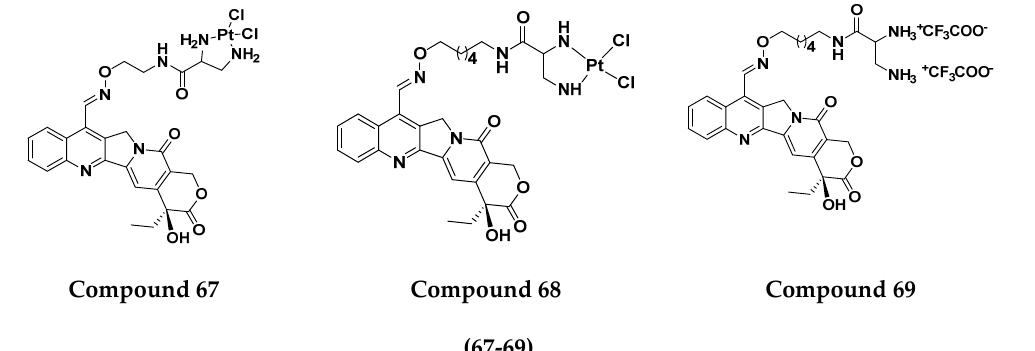
Figure 66. Structure of Camptothecin-linked platinum hybrid derivatives ( 67 – 69 ). Table 53. In vitro cytotoxic activities of camptothecin ‐ linked platinum hybrid compounds ( 67 – 69 ).